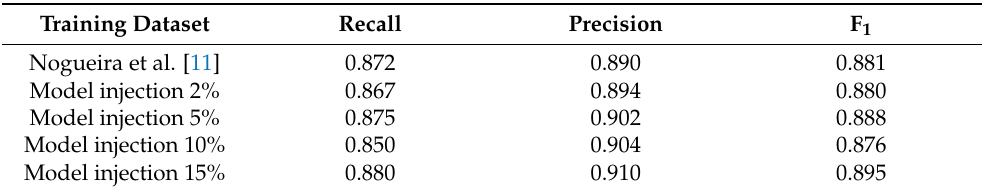
Table 3. Performance metrics of each model on the original test partition of Nogueira et al., which does not contain not-polyp